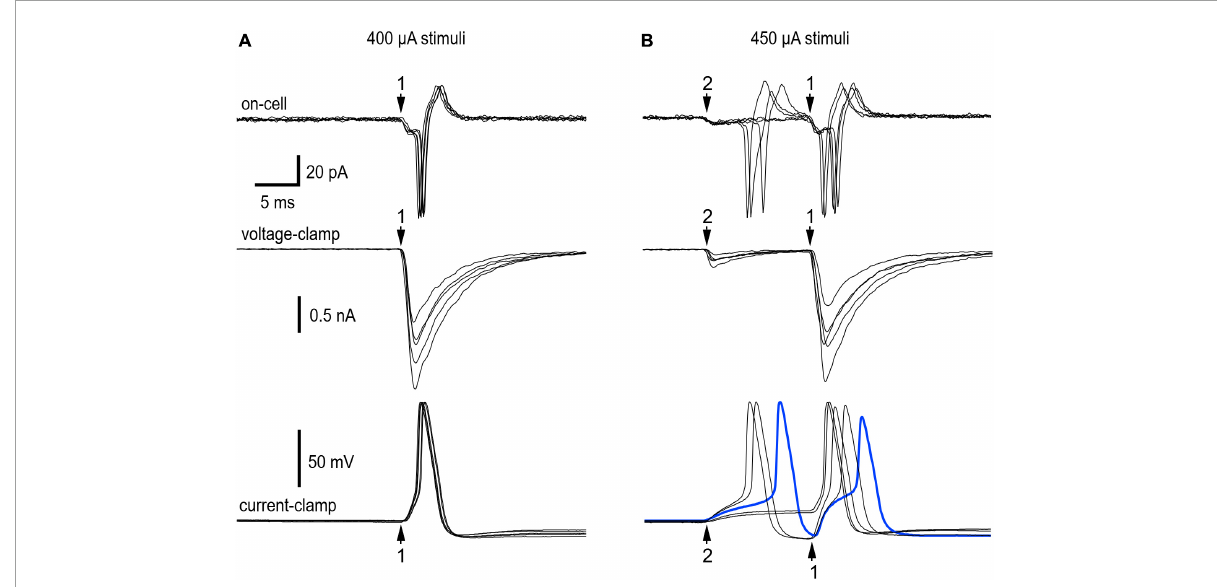
FIGURE2 Resolution of convergence between a primary synapse and a straddling synapse. Extracellular on-cell recordings (top panels) and intracellular whole-cell recordings under voltage-clamp (middle panels) and current-clamp (bottom panels) made while stimulating the preganglionic cervical sympathetic trunk (CST) at two different shock intensities. (A) 400 µ A shocks selectively recruited synapse 1–a strong primary synapse that never failed during repetitive stimulation at 1 Hz. (B) Raising the stimulus strength to 450 µ A recruited synapse 2, a much weaker synapse that straddled threshold during repeated trials at 1 Hz. At 450 µ A, single shocks could elicit double spikes resulting from convergence. Each panel contains five traces chosen to reflect variability in responses. See text for additional details about all the responses. In the on-cell recordings (top panels) one sees evidence of excitatory postsynaptic potentials (EPSPs) and the action potentials they trigger. The voltage-clamp recordings of excitatory postsynaptic currents (EPSCs) (middle panels) show the temporal correspondence with extracellular recordings and the markedly different EPSC amplitudes at synapses 1 and 2. Under current-clamp (bottom panels) there was little variation in the onset of action potentials driven by synapse 1. This contrasted with the smaller EPSPs at synapse 2, where the onset of action potentials was more variable. Note the heavy blue trace showing an action potential evoked by synapse 2 very shortly before the activation of synapse 1. This resulted in the second action potential having a slower upstroke and lower amplitude. Experiment 11/9/18 cell